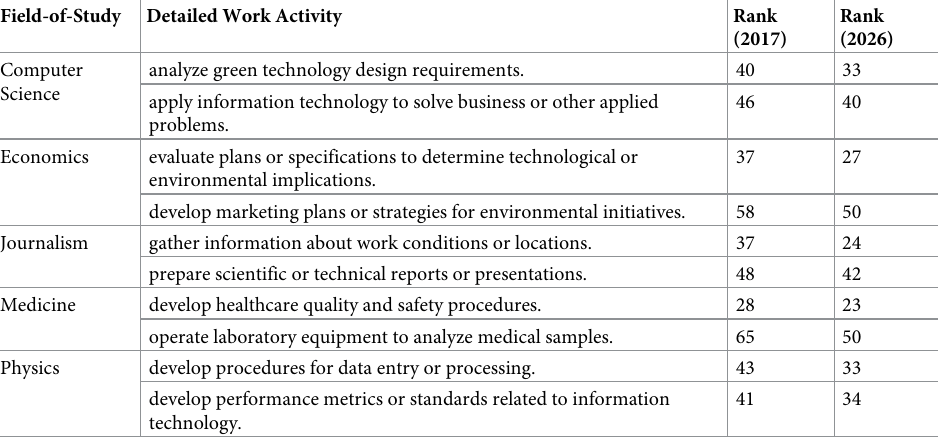
Table 1. Examples of DWAs that are predicted to increase their ranks in 9 years in particular fields. We only select DWAs that are ranked in top 50 in future. The full list of predicted DWAs can be found in the same Github folder.